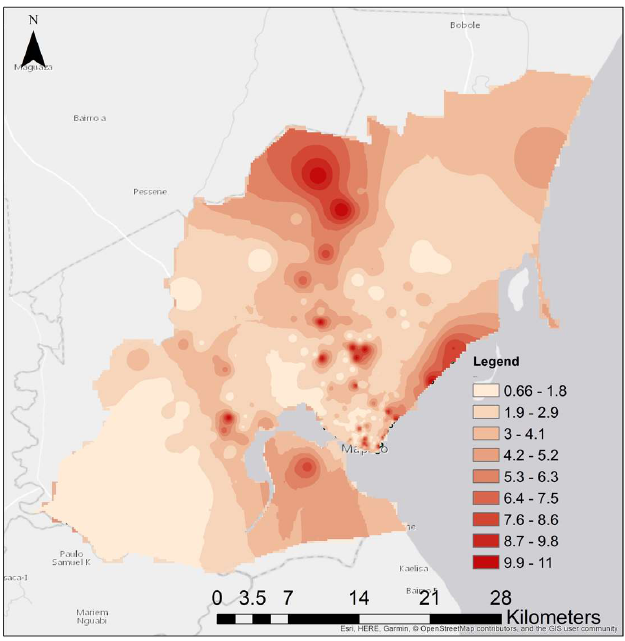
Figure 11. Distribution of user magnification factors ( 𝑢𝑠𝑟_𝑚𝑎𝑔 (cid:3036)(cid:3037) ) in the study area.